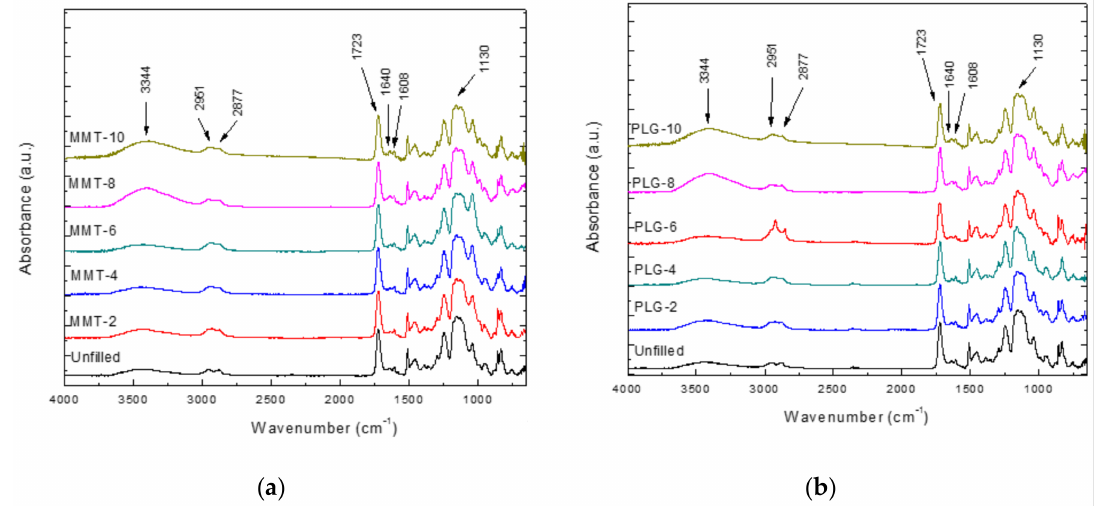
Figure 1. FTIR spectra of nanocomposites prepared with either ( a ) montmorillonite (MMT) or ( b ) palygorskite (PLG).